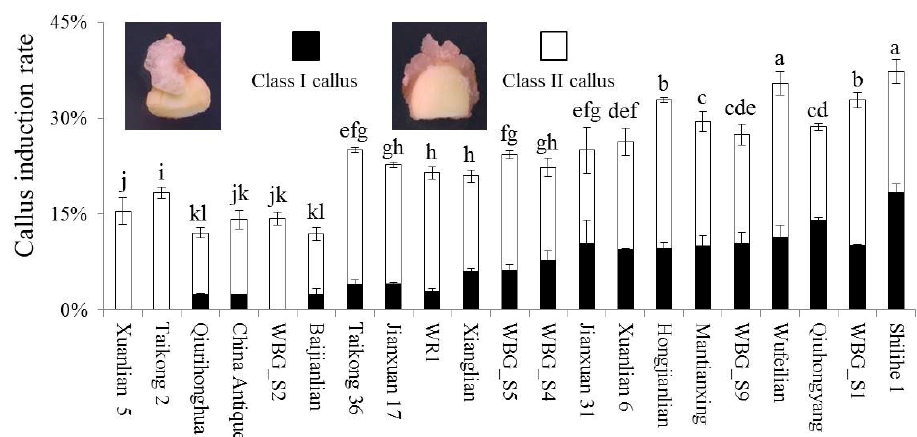
Figure 2. Effects of lotus genotypes on callus induction. Class I calluses indicate those of over 0.5 × 0.5 × 0.5 cm 3 , and class II indicates calluses smaller than 0.5 × 0.5 × 0.5 cm 3 . Different subcase letters indicate significant differences at p < 0.05.